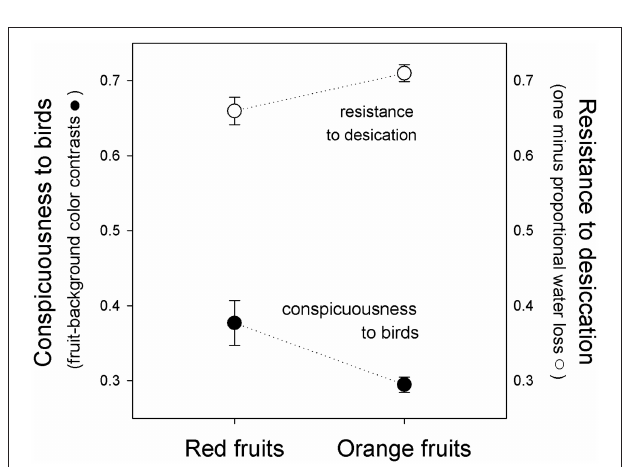
FIGURE 3 | Fruit conspicuousness (Euclidian distance between fruits and leaf backgrounds in tetrahedral color space, black symbols, ± se), and resistance to desiccation (one minus the proportion of water lost after 24h of exposure to sunlight, white symbols), of red (left) and orange (right) fruits of Rubus spectabilis